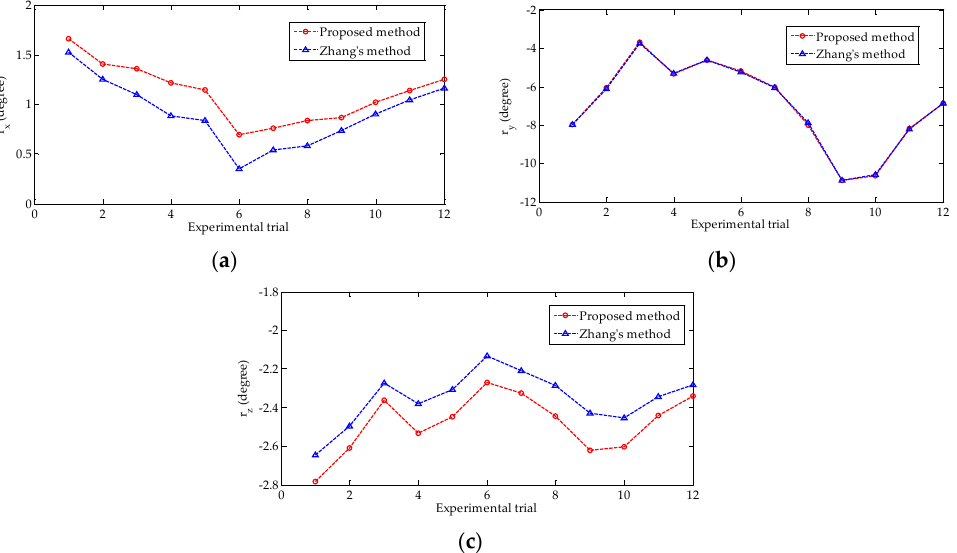
Figure 9. Euler angles estimated by using the proposed and Zhang’s methods: ( a ) r x of the two methods; ( b ) r y of the two methods; ( c ) r z of the two methods. Sensors 2018 , 18 , x FOR PEER REVIEW